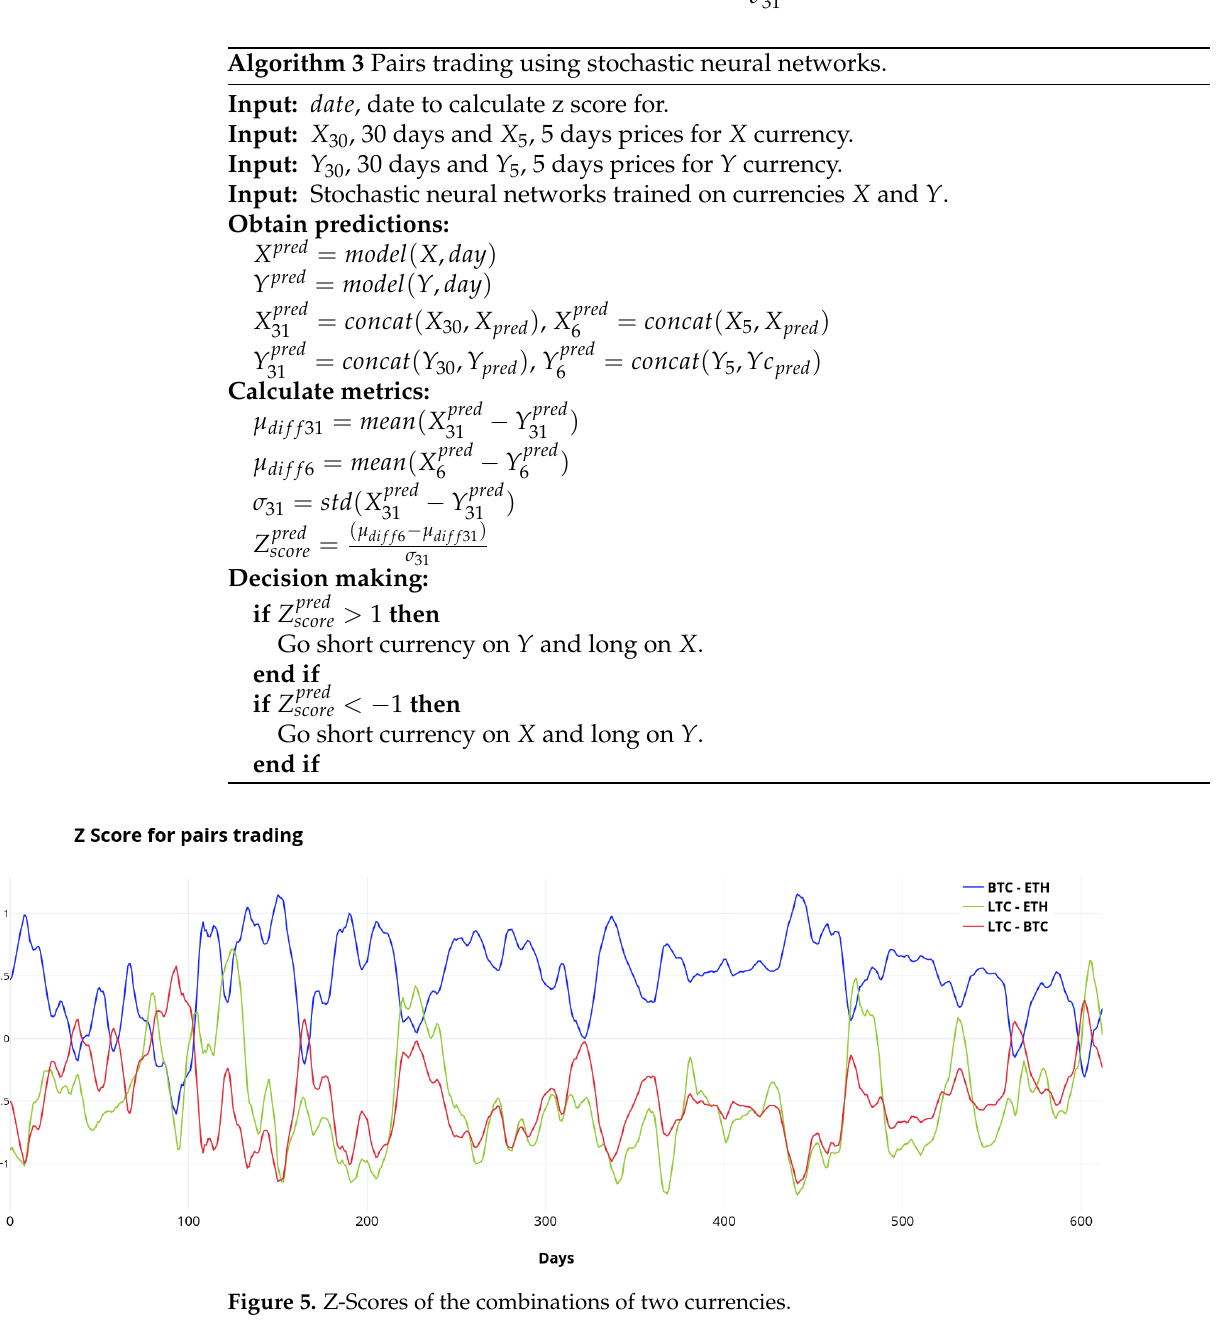
Figure 5. Z-Scores of the combinations of two